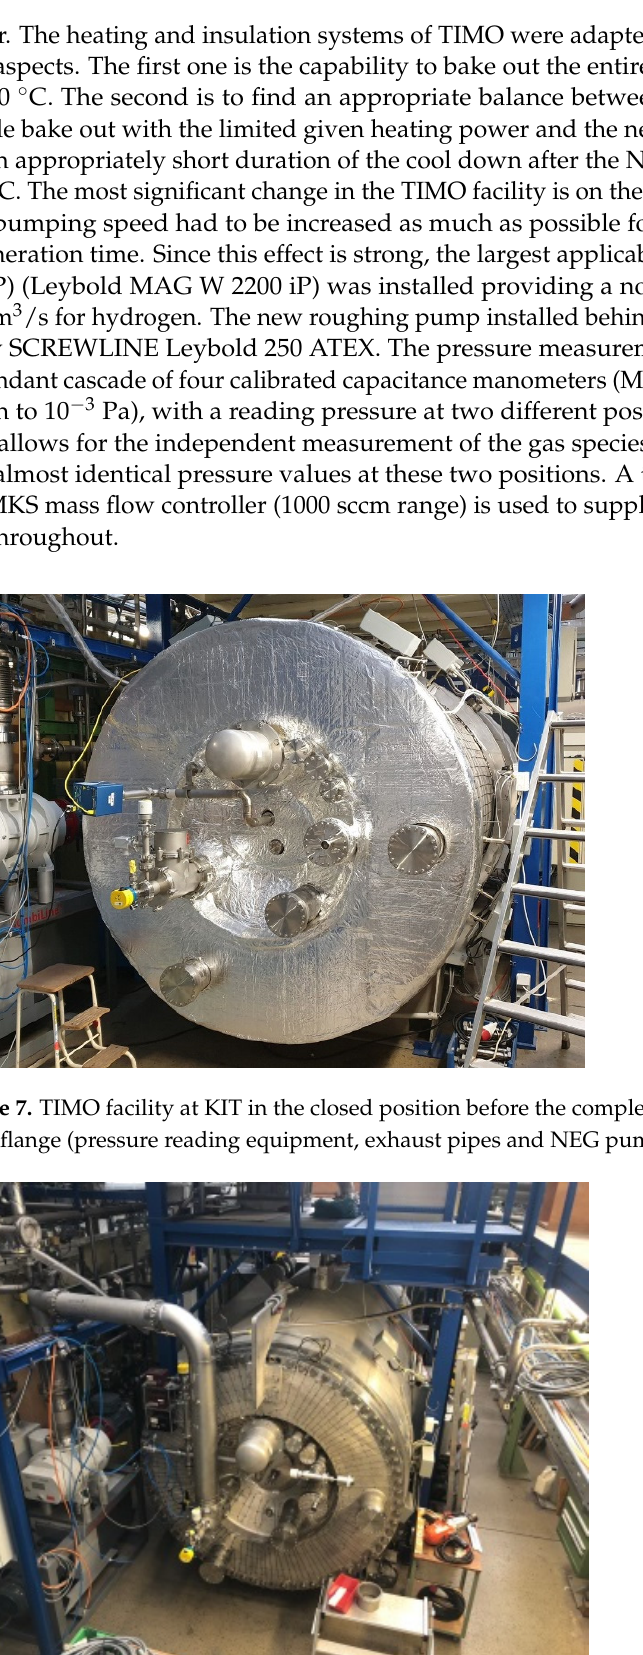
Figure 8. Bird’s eye view of the TIMO facility before the main flange insulation for the vessel bake out after air exposure.